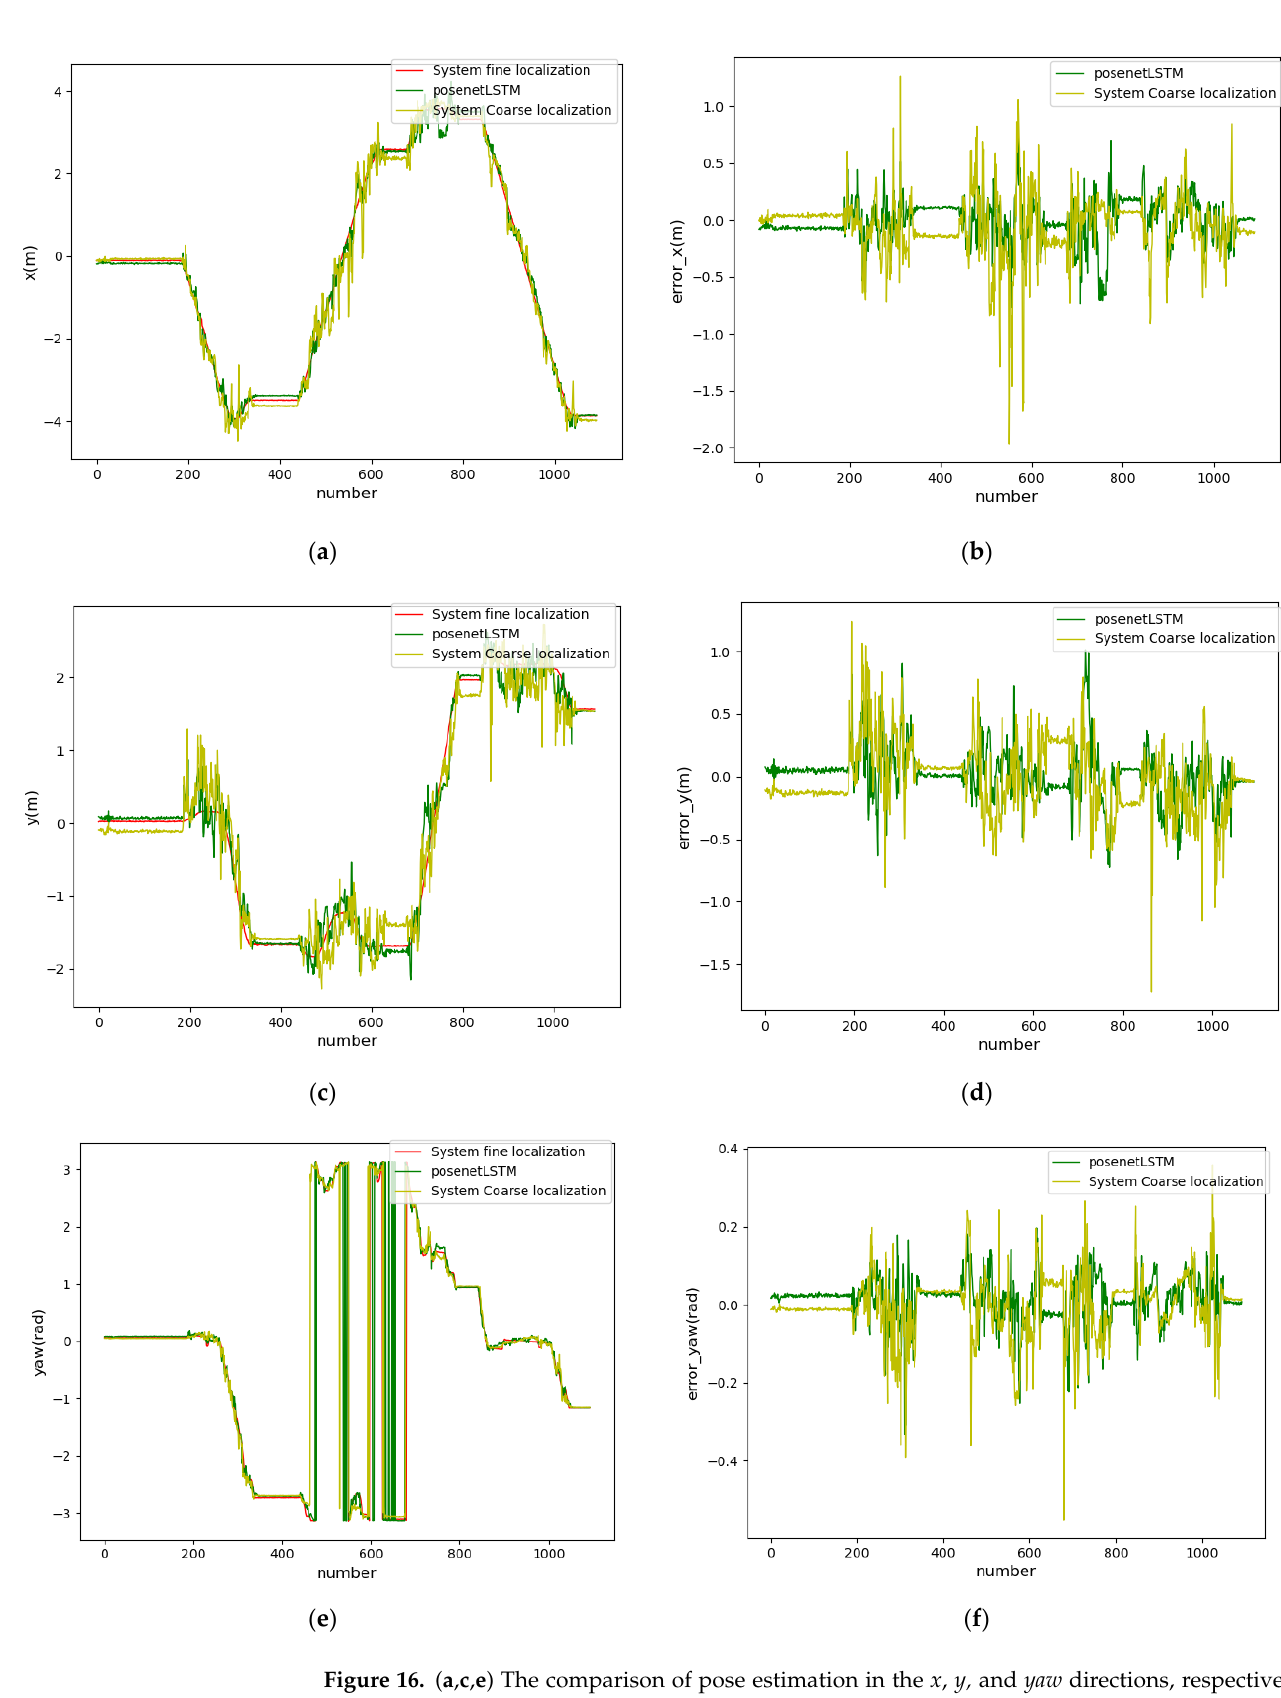
Figure 16. ( a , c , e ) The comparison of pose estimation in the x , y, and yaw directions, respectively; ( b , d , f ) The comparison of pose estimation errors in the x , y , and yaw directions, respectively.